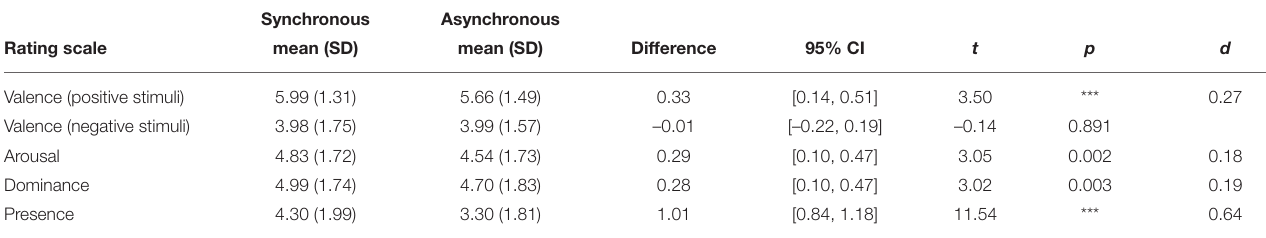
TABLE 1 | Mean comparisons.